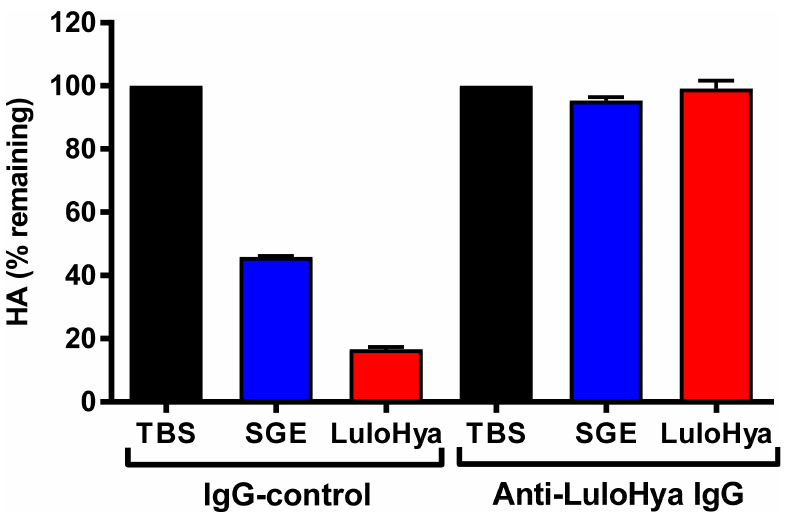
Fig 8. Anti-LuloHya antibodies block the hyaluronidase activity of SGE and LuloHya. Hyaluronidase activity of Lu . longipalpis SGE and 10 nM LuloHya in the presence of 5 μg of rabbit IgG-control (pre-immune IgG) or 5 μg of rabbit anti-LuloHya IgG. As negative controls, TBS was added instead of SGE or recombinant protein. Biological triplicates were tested. Bars indicate